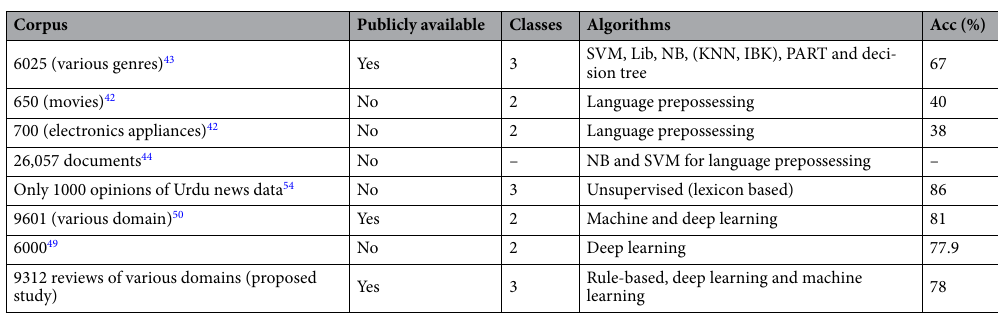
Table 1. Summary of existing Urdu datasets.